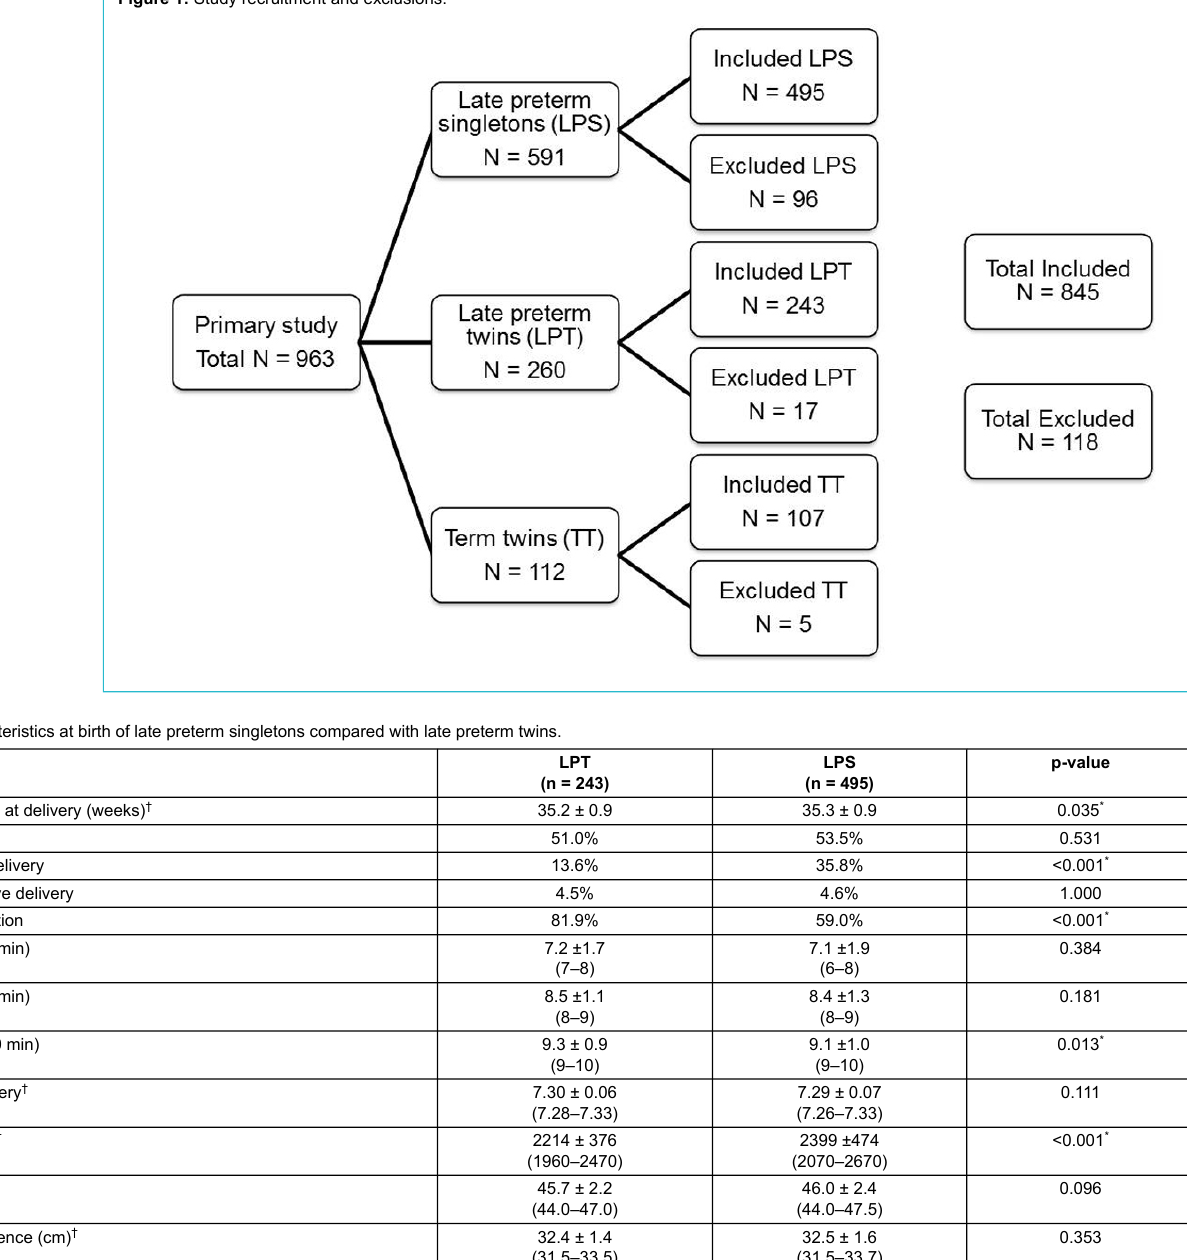
Figure 1: Study recruitment and exclusions.